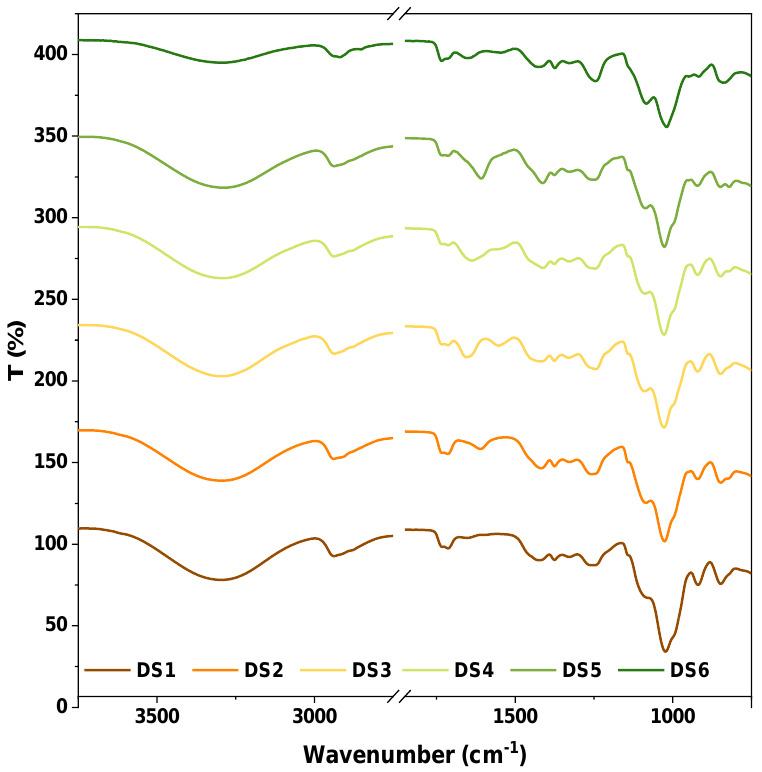
Figure 2. FTIR spectra of the nanocomposite films.